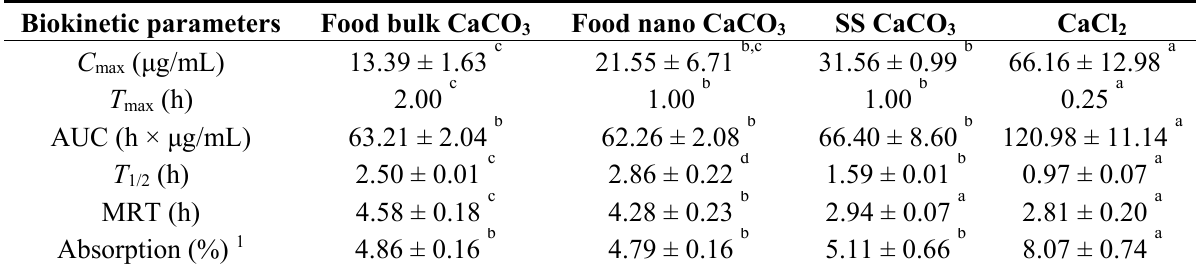
Figure 7. Plasma concentration-time curves of three different types of CaCO 3 particles (250 μ g/mL) or an equivalent amount of CaCl 2 (based on calcium content) after a single-dose oral administration to female rats. Biokinetic data are presented as increase in calcium levels after subtracting the basal plasma calcium levels detected in untreated controls. Table 1. Biokinetic parameters and oral absorption of calcium carbonate (CaCO 3 ) particles after oral administration to